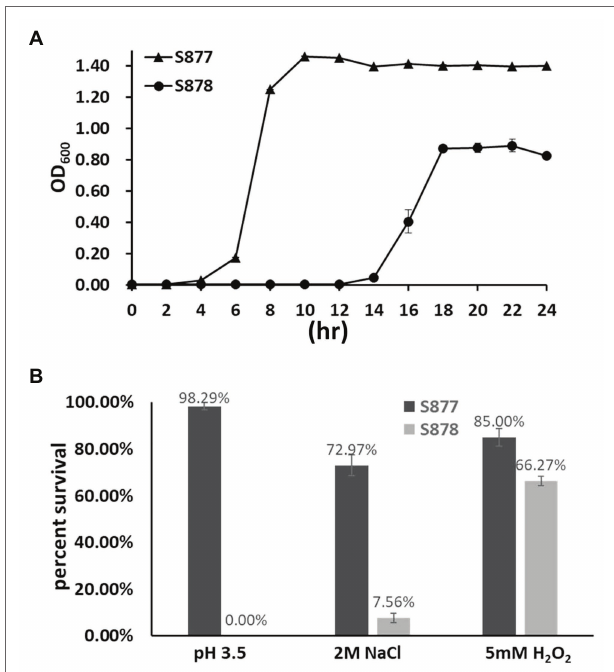
FIGURE 5 | Characterization of the ftsH deletion strain. (A) Growth kinetics of the markerless vicR (G195R) point mutation strain (S877) and its derivative ftsH deletion strain S878 under normal culture conditions at pH 7.0. (B) Tolerance of strains S877 and S878 to acid, osmotic, and oxidative stresses. Exponential cultures of S. mutans S877 and S878 were exposed to acid stress at pH 3.5 for 20 min., osmotic stress with 2 M NaCl for 3 h., and oxidative stress with 5 mM H 2 O 2 for 1 h. After stress exposure, serial dilutions of the cultures were plated onto BHI agar to determine the number of viable cells. Similar cultures not exposed to stress were used as controls. Colony forming unit (CFU) were counted and percent survival of strains S877 (black bars) and S878 (gray bars) was calculated relative to the control samples. Data are presented as the means ± standard deviations from three biological